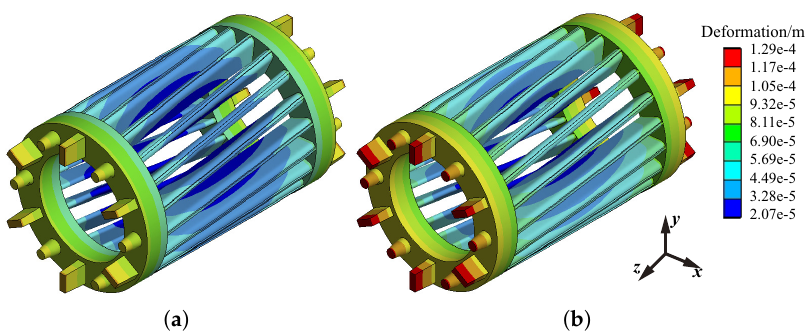
Figure 13. Deformation of squirrel cage rotor before and after the fault. ( a ) Normal. ( b ) Forty-five- turn fault.